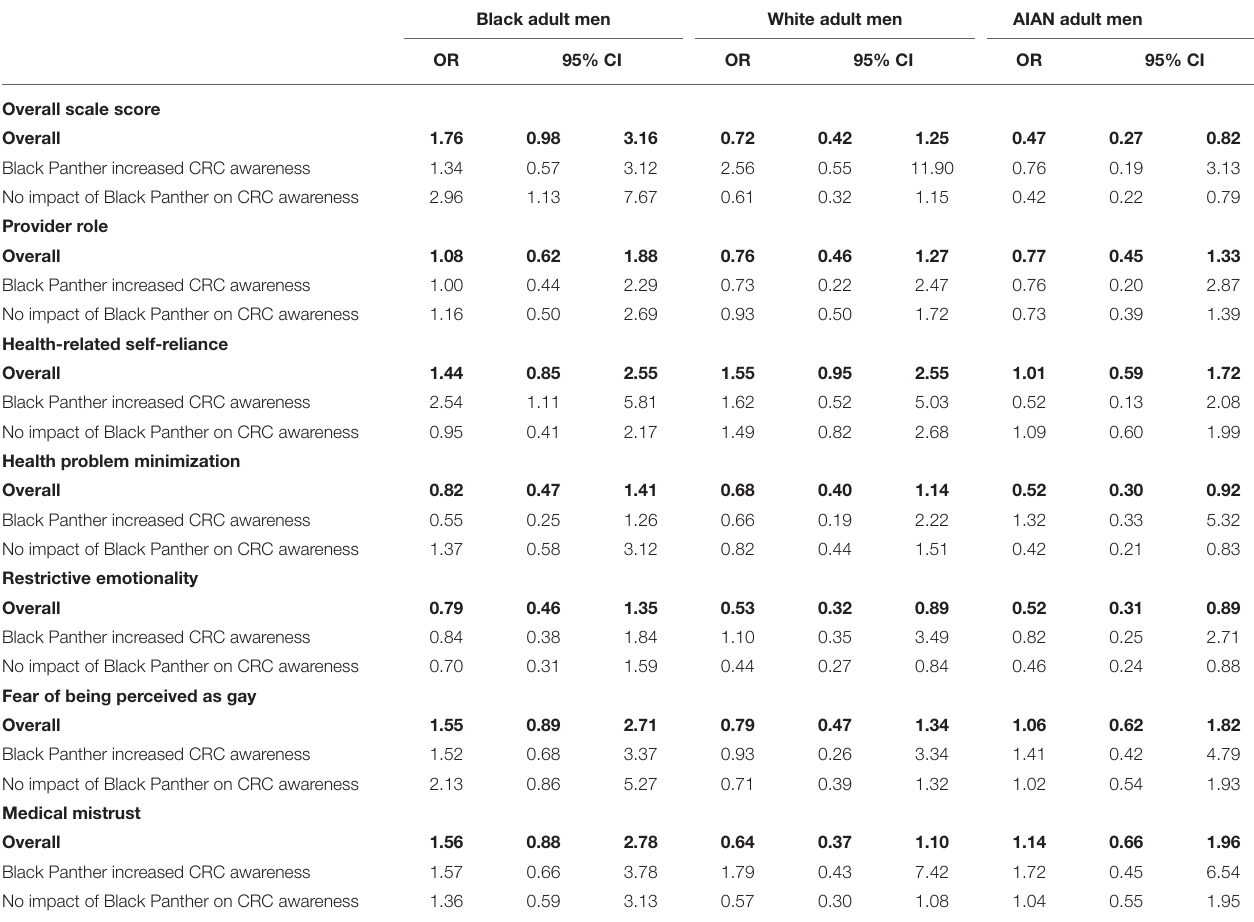
TABLE 2 | Associations of masculinity barriers to health care with intention to screen for CRC among racial ethnic minority men. Black adult men White adult men AIAN adult men OR 95% CI OR 95% CI OR 95%